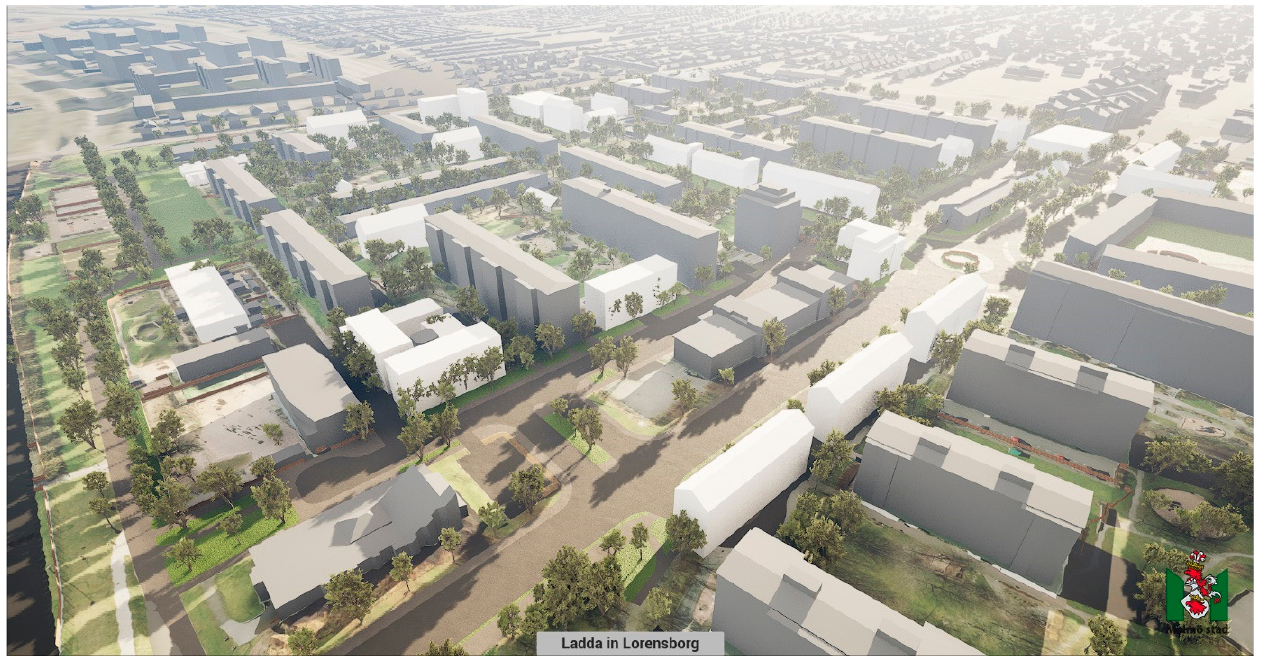
Figure 14. Visualisation of the 3CIM test data for Malmö in Unreal Engine. The white buildings are planned buildings. Viewing from north-east.